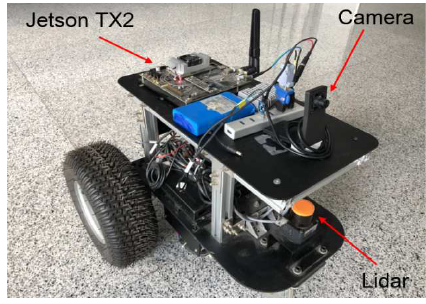
Figure 6. The mobile robot used to perform ERF-IMCS